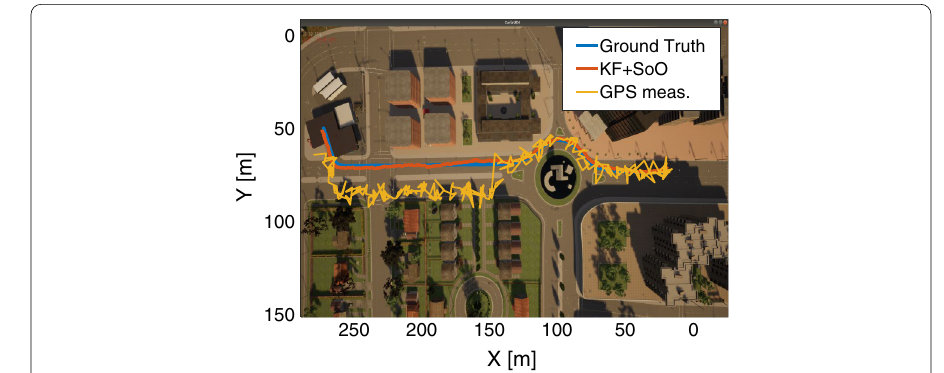
Fig. 8 Example of a GPS spoofing attack in CARLA simulator